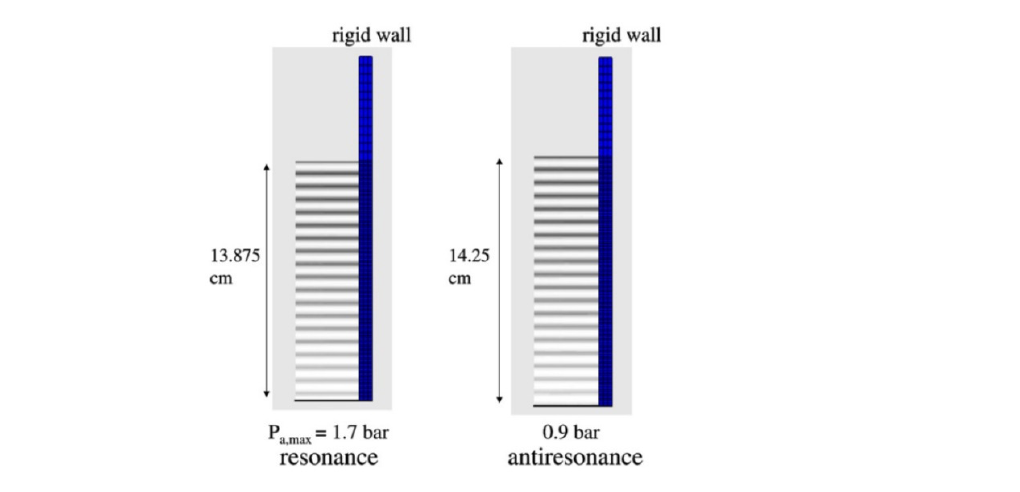
Figure 21. The calculated spatial distribution of the acoustic amplitude for glass wall (7 mm in thick- ness) for various attenuation coefficients of ultrasound [66]. The full-width at half maximum for the Gaussian distribution of the vibration amplitude of the vibrating plate at the bottom is 5 cm. The wall height is 20 cm. A half of the width (the full width is 7 cm) of the liquid container is shown. The photograph of sonochemiluminescence from an aqueous luminol solution is also shown for the corresponding half plane. Copyright 2007, with the permission from Elsevier.